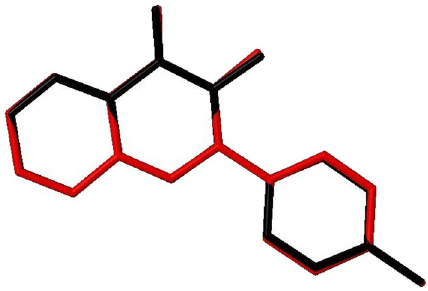
Figure 15. Superimposition atom-by-atom of the compound 12 calculated using DFT/6-31G(d, p) (red) over the X-ray structure (black). Hydrogen atoms omitted for clarity.